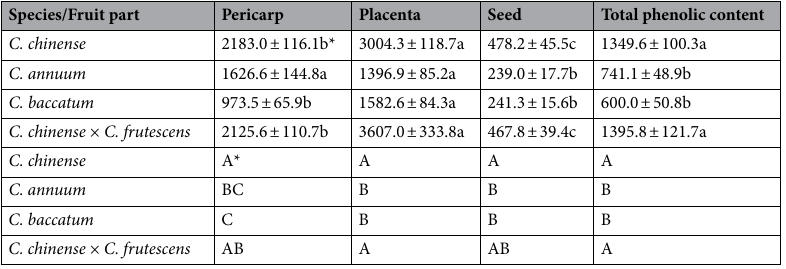
Table 3. Total phenolic content (mg GAE/100 g DW, mean ± SE) in different species and three fruit parts. * a–c Lower case letters denote statistical significant differences (α < 0.05) among placenta, pericarp and seeds of total phenolics in same species. * A–C Upper case letters in same column denote statistical significant differences (α < 0.05) in total phenolics among placenta, pericarp, seeds and whole fruit in four different